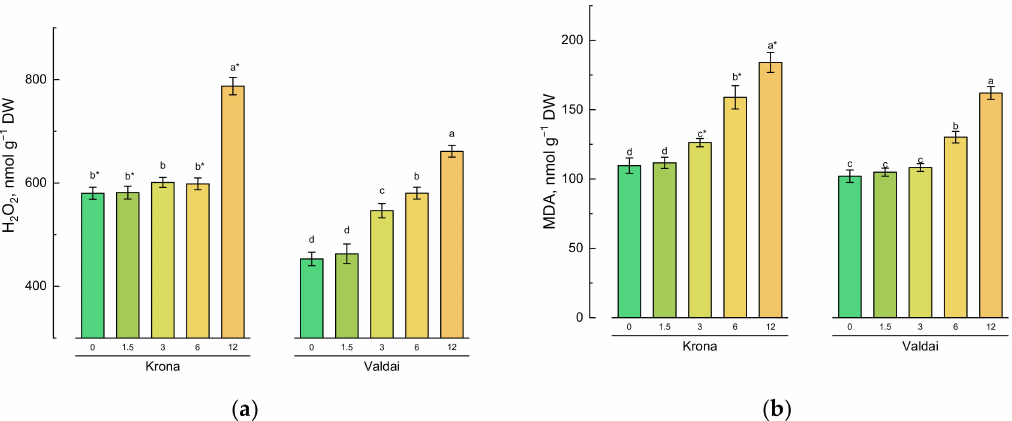
Figure 2. Effect of soil pollution with crude oil (given on X -axis in %) on ( a ) hydrogen peroxide content and ( b ) malondi- aldehyde (MDA) content in shoots of two rye varieties. Different lower-case letters indicate significant differences between plants by oil concentration in the soil for each variety separately, and asterisks * indicate significant differences between rye varieties at p ≤ 0.05 based on post hoc Tukey’s test ( n =